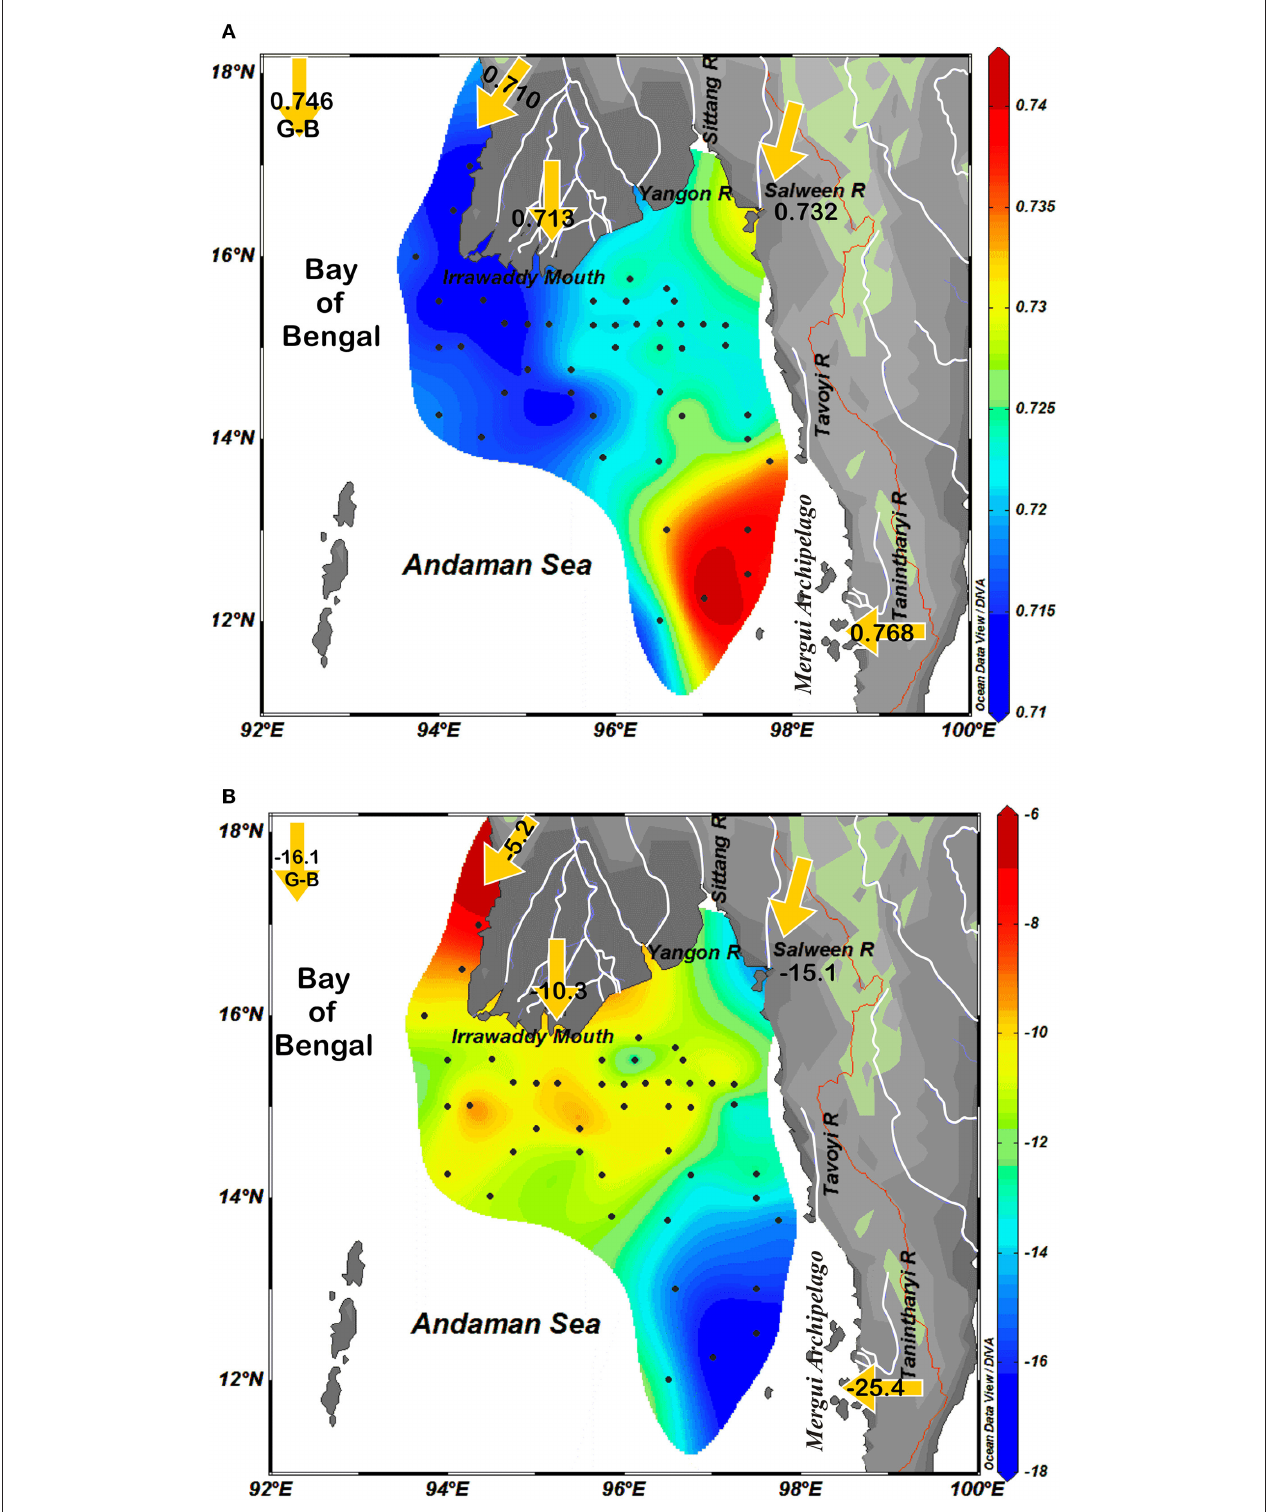
FIGURE 6 | Distribution patterns of (A) 87 Sr/ 86 Sr and (B) ε Nd in the Western Myanmar, Northern and Eastern Andaman Basin. Both these patterns indicate four dominant sources of sediments, (i) rivers from the Arakan Coast, (ii) The Irrawaddy River, (iii) the Salween River, and (iv) the Tanintharyi and other smaller rivers draining Southern